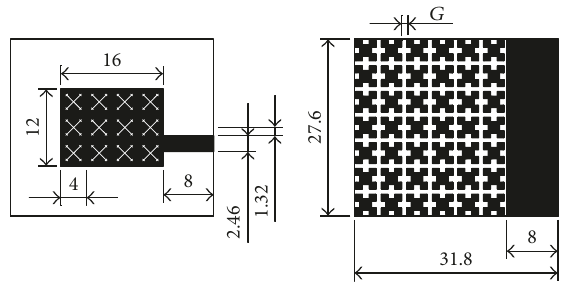
Figure 3: The proposed double-fractal antenna geometry.